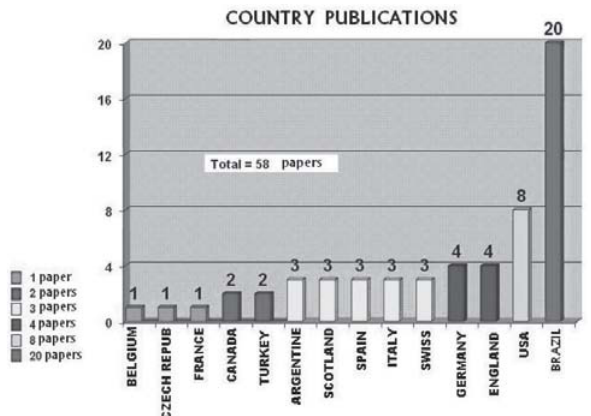
Fig. 2 - Distribution of the papers by country origin